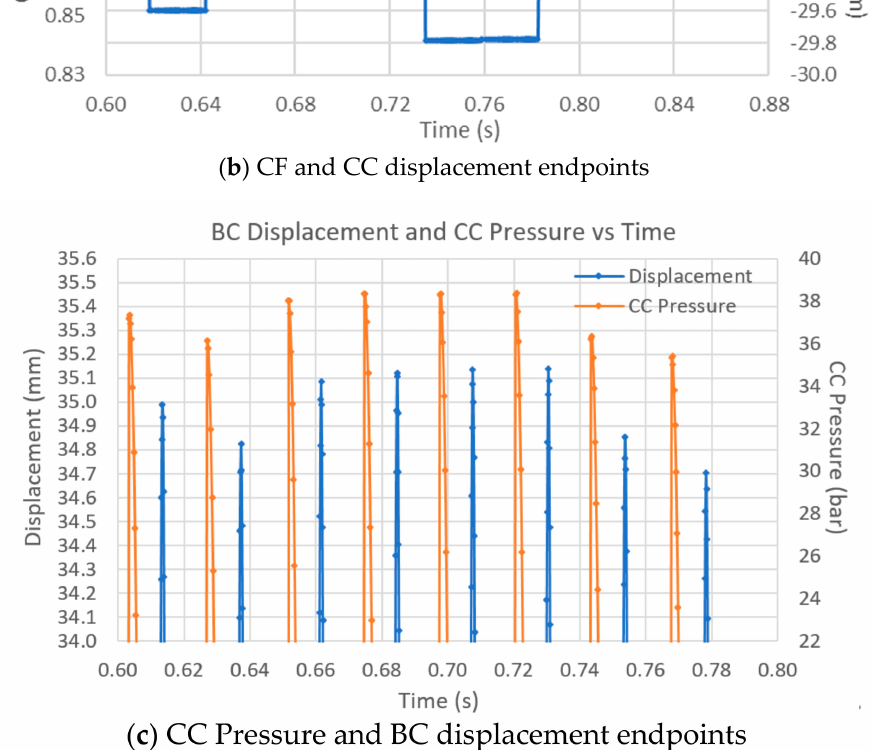
Figure 20. ( a ) CF and CC pressure vs. time, ( b ) CC pressure and CC displacement endpoints vs. time, ( c ) CC pressure and BC displacement endpoints vs. time at 0.91 ±